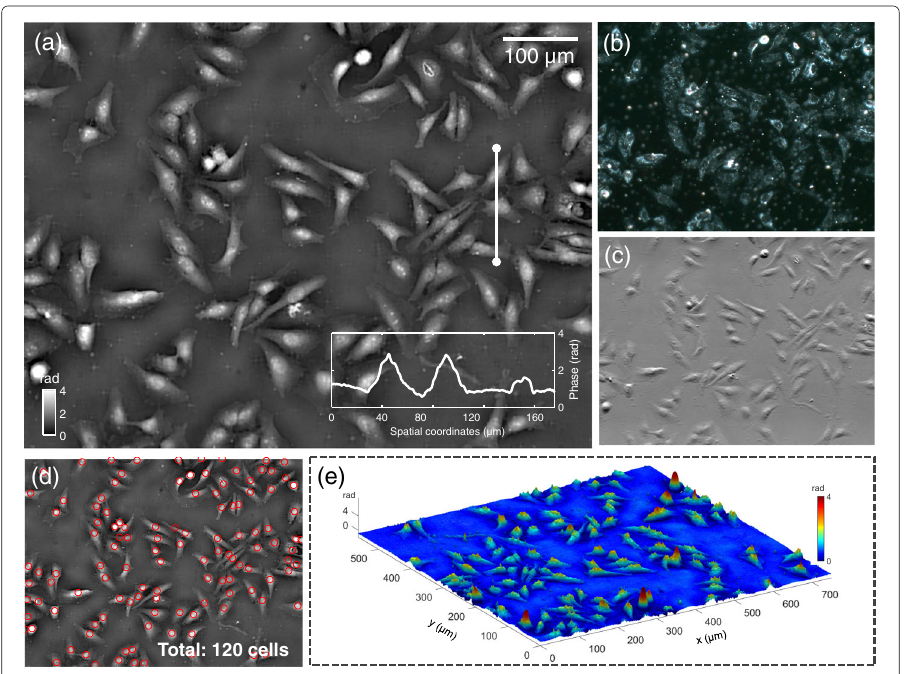
Fig. 25 Reconstruction quantitative phase of HeLa cells. (a) Reconstruction quantitative phase and quantitative profile of HeLa cells. (b) Dark field visualization image. (c) Phase gradient image under DPC imaging. (d) Cell counting display (120 cells in full FOV). (e) 3D pseudo-color phase profile display of HeLa